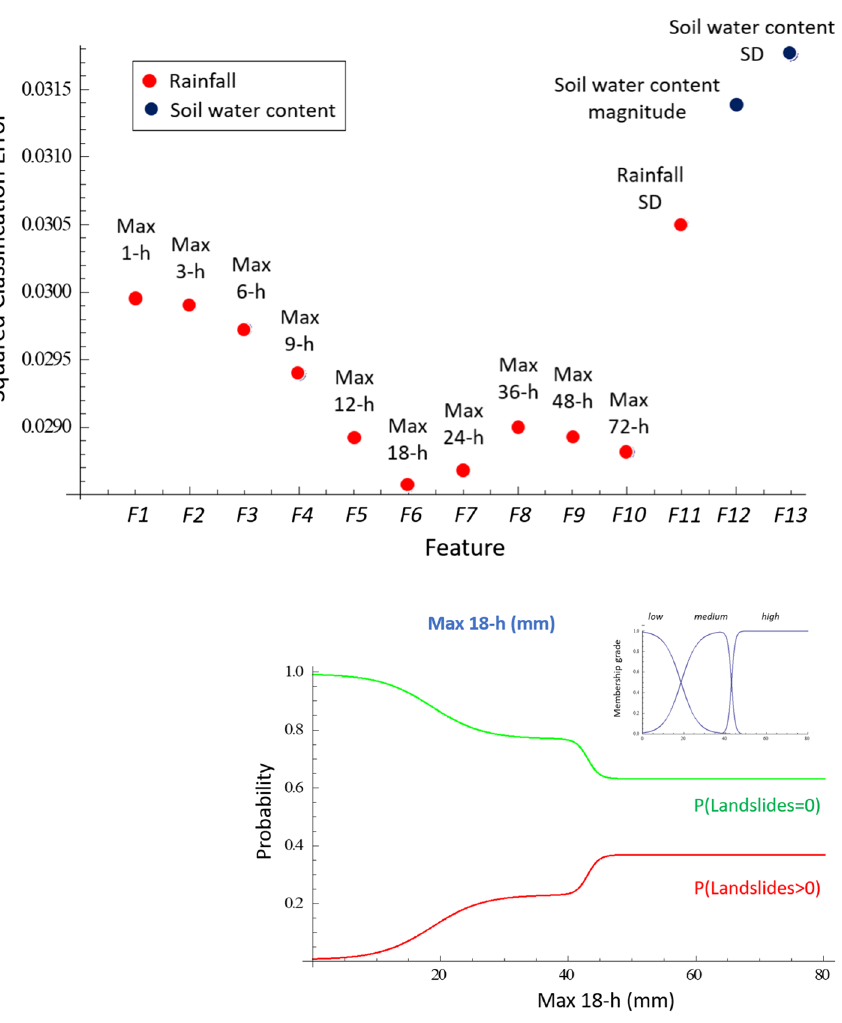
Fig. 3 Trend of the objective function for models defined using, individually, the 13 variables calculated with daily time discretization